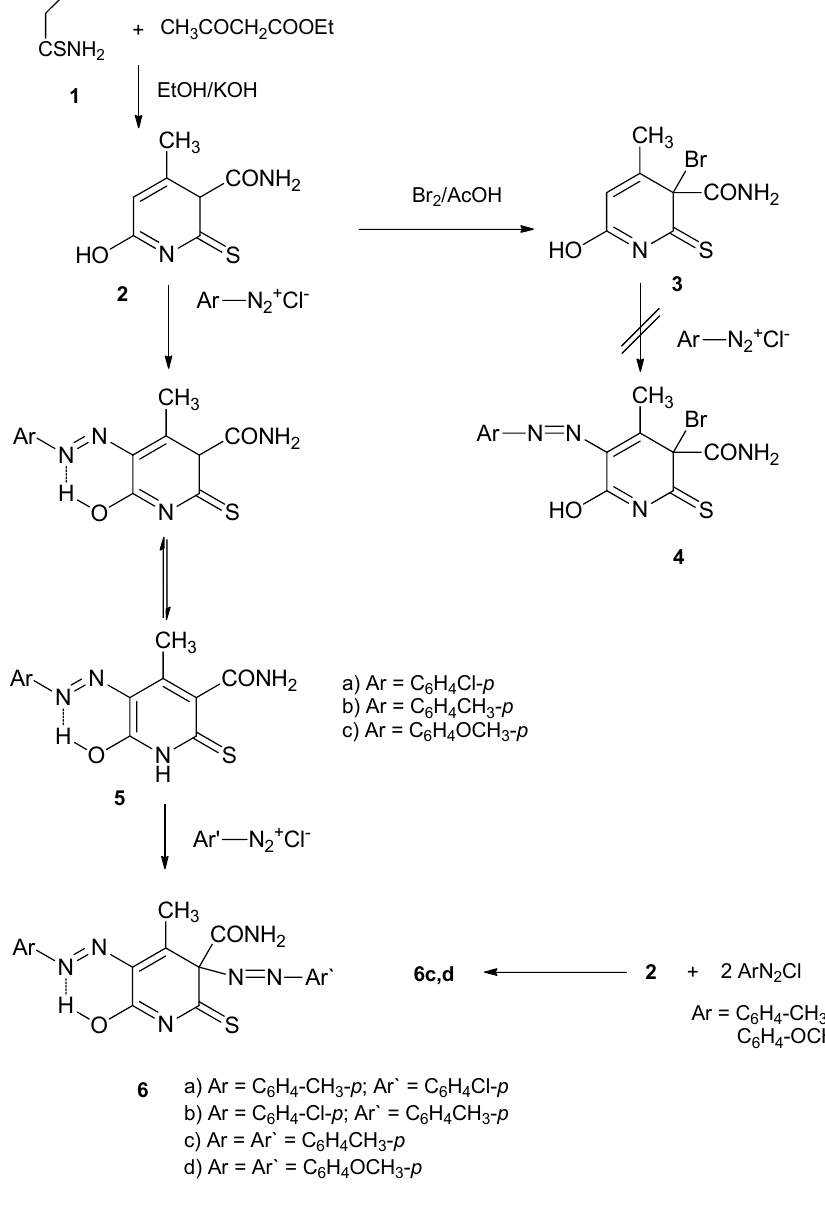
Scheme 1. Bromination and diazo coupling of the pyridinethione derivative 2